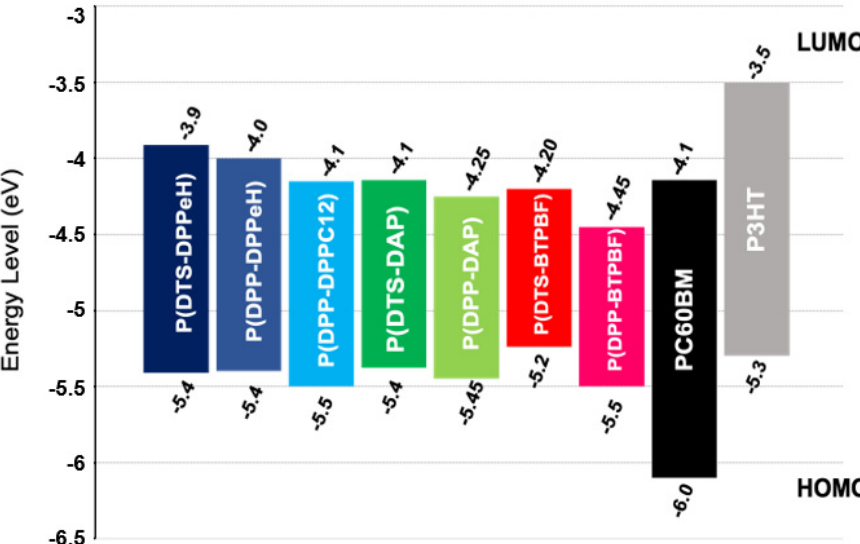
Figure 5. HOMO-LUMO energy levels of the copolymers (A-A’) based on DPP and (D-A) based on DTS determined by cyclic voltammetry.